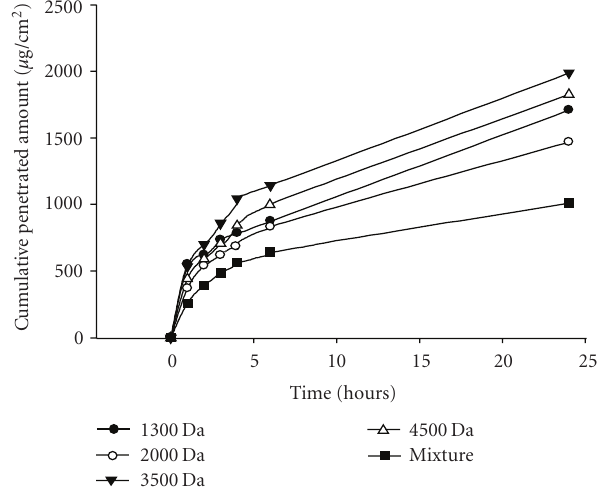
Figure 5: Transdermal permeation abilities of given FSCPs frac- tions. The permeation abilities of various molecular sizes of FSCPs were determined by the Franz-type di ff usion cell model, performing at 1, 2, 3, 4, 6, and 24 hours. The amounts of total collagen peptides from the receptor solutions were determined by the BCA protein assay. “Mixture” indicates the FSCP hydrolates without ultracentrifugation membrane treatment. The results shown are a representative in 3